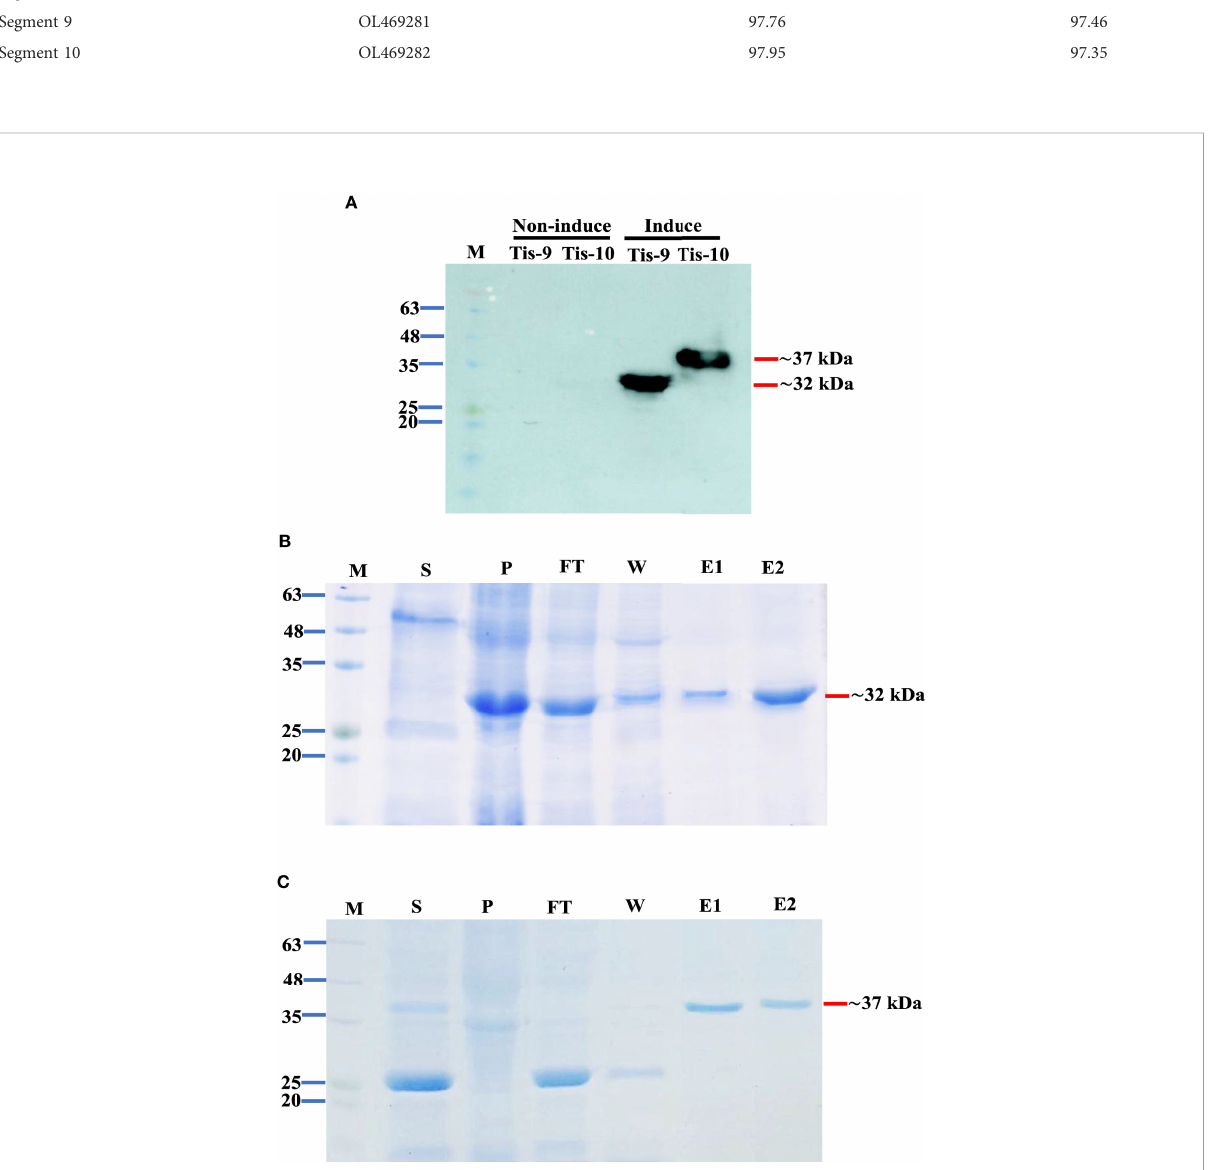
FIGURE 2 Expression and puri fi cation of Tis9 and Tis10 proteins. (A) Western blot analysis of both proteins from the E. coli expression system. Tis9 and Tis10 proteins expressed approximately 32 kDa and 37 kDa, respectively (Lane M: prestained protein marker). (B, C) SDS-PAGE analysis of (B) Tis9 and (C) Tis10 proteins puri fi cation with coomassie blue staining. (Lane M: prestained protein marker; Lane S: supernatant; Lane P: precipitation of the E. coli was induced; Lane F: unbound fl owthrough; Lane W: wash fraction; Lanes: E1-E2 = elute fractions.